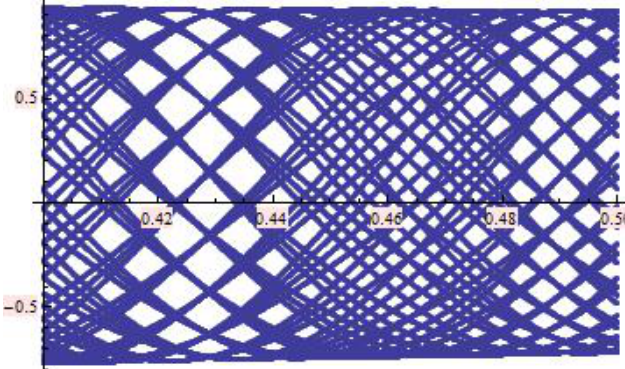
Figure 3. B.D. in ( β − x ) —plane, β between 0.4 and 0.5, α = − 1.9 and the initial conditions ( 0.1,0.2 ) .